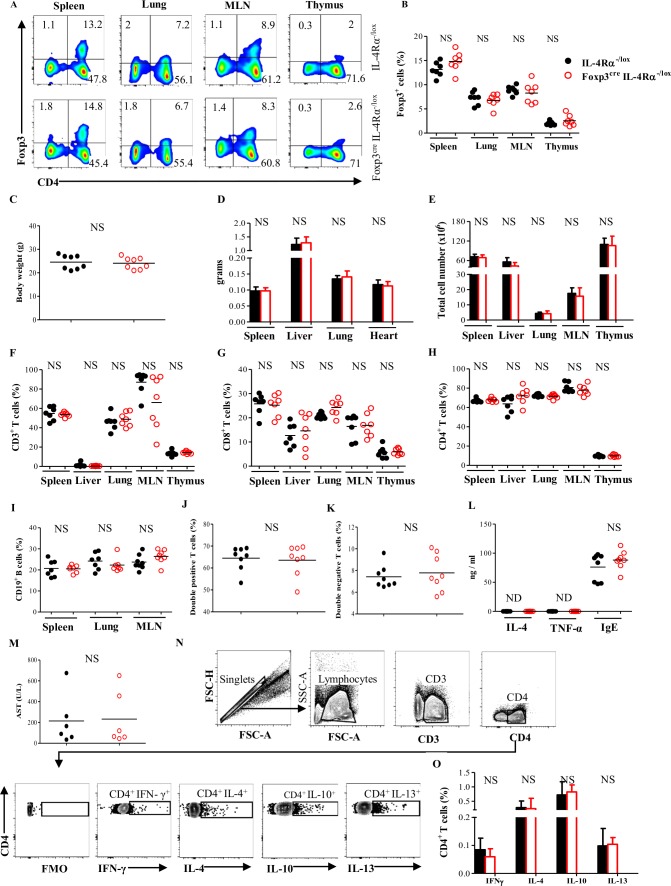
Deletion of IL-4Rα on Foxp3+ Treg cells does not break immune tolerance under a steady state.(A) Representative flow cytometry analysis of CD4+ Foxp3+ cells among CD3+ cells from spleen, lung, MLN, and thymus of naïve IL-4Rα−/lox and Foxp3cre IL-4Rα−/lox mice. (B) Frequency of CD4+ Foxp3+ T cells from (A). (C) Body weight of naïve IL-4Rα−/lox and Foxp3cre IL-4Rα−/lox mice. (D) Organ weights of naïve mice. (E) Total cell number of spleen, liver, lung, MLN, and thymus of naïve mice. (F) Frequency of CD3+, (G) CD3+ CD8+, and (H) CD3+ CD4+ T cells from organs of mice as in (E). (I) Frequency of CD19+ B cells in spleen, lung, and MLN of naïve mice. (J) Frequency of double-positive and (K) double-negative T cells in the thymus of naïve mice. (L) Serum analysis of naïve mice. (M) Analysis of liver function in naïve mice. (N) Gating strategy for identifying cytokine-producing CD4+ T cells. (O) Frequency of IFN-γ, IL-4, IL-10, and IL-13-expressing CD4+ T cells. MLN cells from naïve mice were restimulated with PMA/Ionomycin in the presence of monensin, after which CD4+ T cells stained intracellularly for indicated cytokines. Results are representative of two independent experiments with 7–9 mice/group. Data are expressed as mean ± S.E.M. NS, P > 0.05; * P < 0.05, ** P < 0.001, *** P < 0.0001 by two-tailed unpaired Student t test. Underlying data can be found in S1 Data. AST, aspartate aminotransferase; CD3, cluster of differentiation 3; CD4, cluster of differentiation 4; CD8, cluster of differentiation 8; CD19, cluster of differentiation 19; FMO, fluorescence minus one; Foxp3, forkhead box P3; FSC, forward scatter; IFN-γ, interferon gamma; IgE, immunoglobulin E; IL-4, interleukin-4; IL-10, interleukin-10; IL-13, interleukin-13; IL-4Rα, interleukin-4 receptor alpha; MLN, mesenteric lymph node; ND, not detectable; NS, not significant; PMA, phorbol myristate acetate; SSC-A, side scatter A; TNF-α, tumor necrosis factor alpha; Treg, regulatory T.